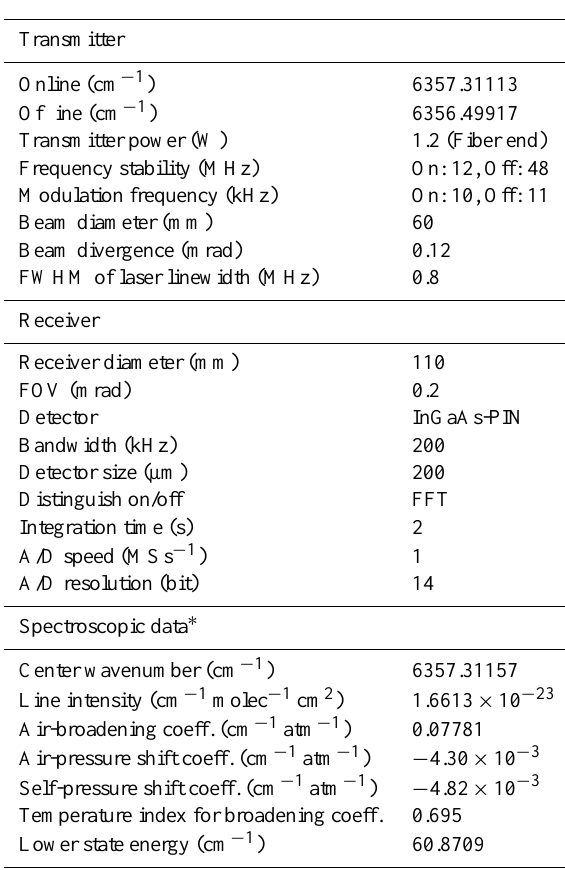
Table 2. Specifications for instrumental and spectroscopic data.